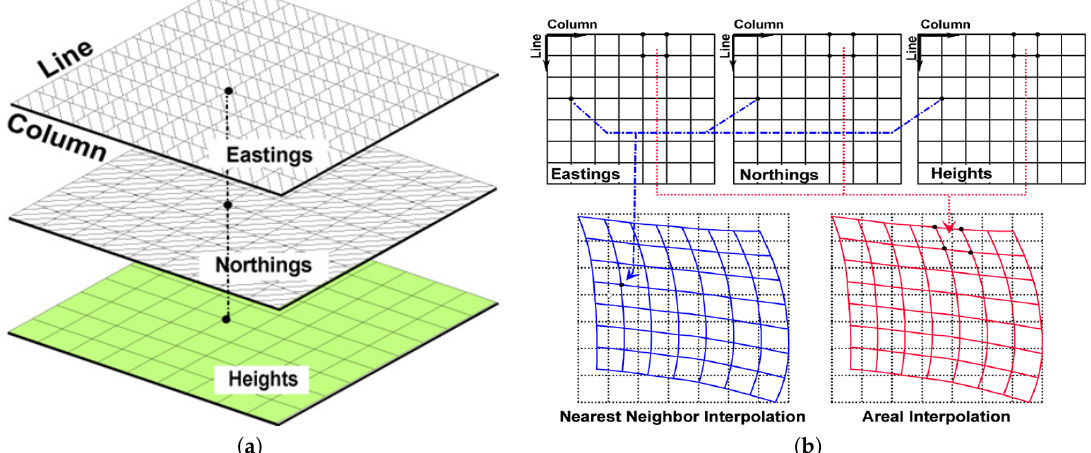
Figure 12. DSM resampling: ( a ) representation of 3D point cloud as a multi-band image and ( b ) regridding